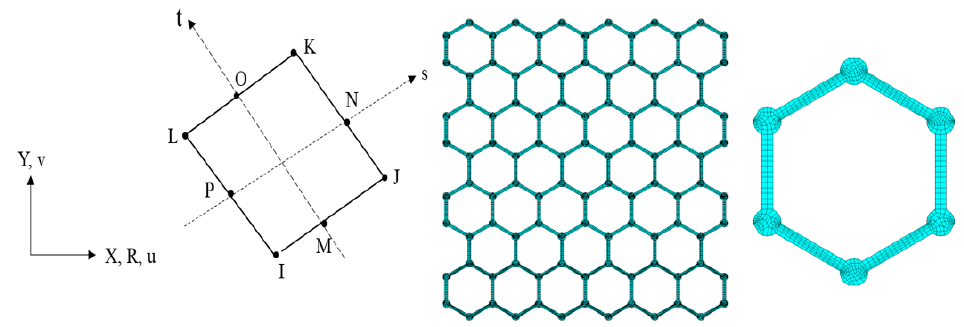
Figure 4. The two-dimensional 8-node quadrilateral element for the finite plane element model. The shape functions of the two-dimensional 8-node quadrilateral element in the finite plane element model are expressed as,